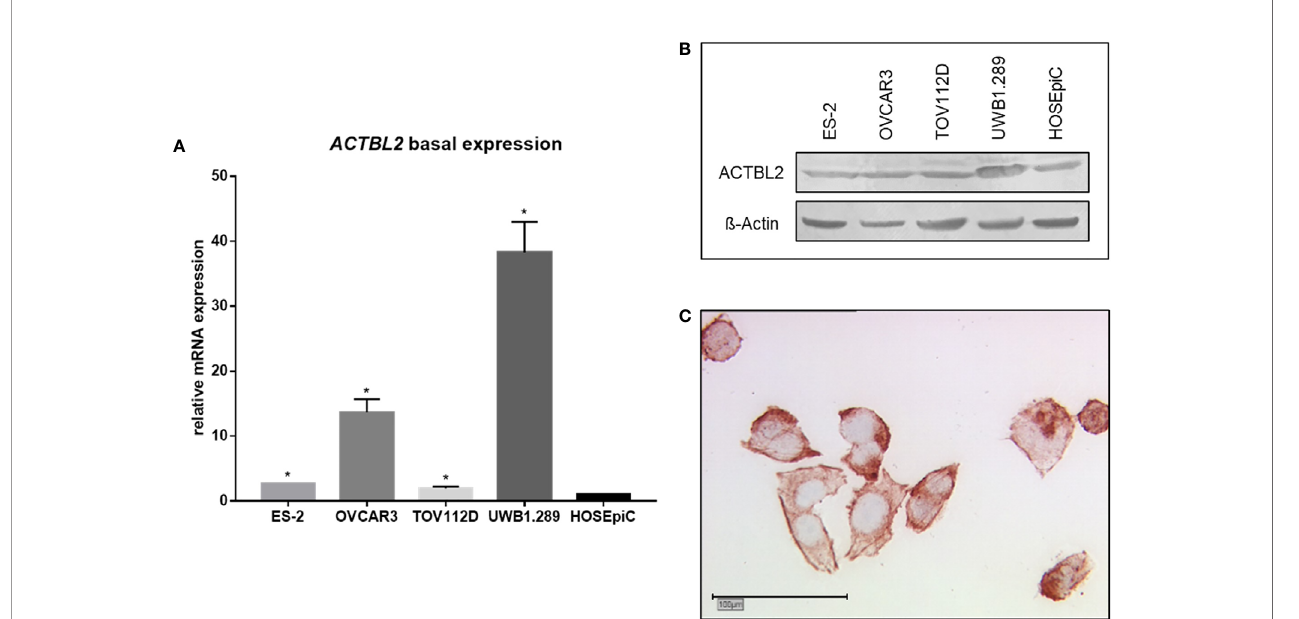
FIGURE 2 | Basal expression of ACTBL2 in ovarian cancer cell lines. (A) qPCR results showing ACTBL2 expression in four EOC cell lines (ES-2, OVCAR3, TOV112D, UWB1.289) compared to the benign control cell line (HOSEpiC; n=6; * p =0.028). (B) Exemplary Western blot analysis of ACTBL2 expression (42 kD) in four EOC cell lines (ES-2, OVCAR3, TOV112D, UWB1.289) compared to the benign control cell line (HOSEpiC). (C) Detection of ACTBL2 in UWB1.289 cells by immunocytochemistry. Exemplary photographs (25x magni fi cation; scale bar=100µm) showing protein expression in both cytoplasm and cell membrane.